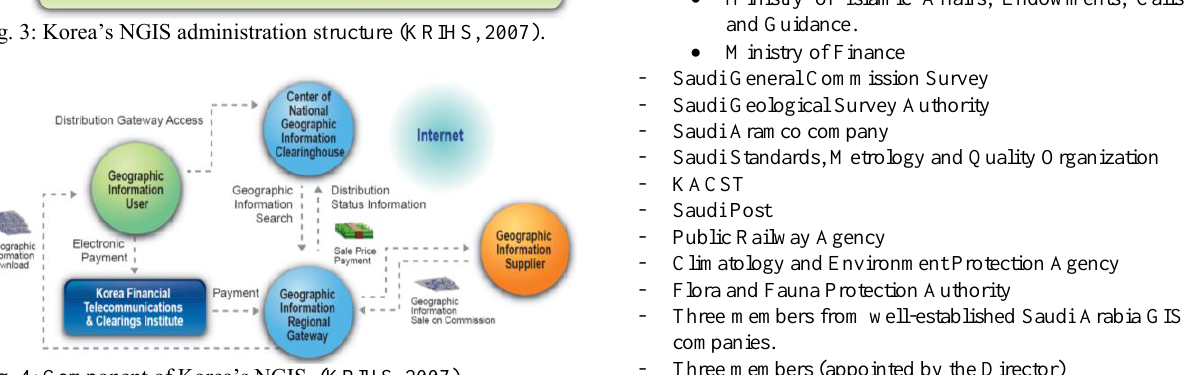
Fig. 4: Component of Korea’s NGIS (KRIHS,